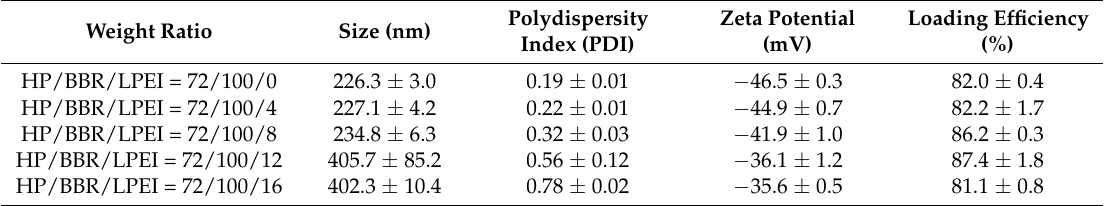
Table 2. Size, zeta potential, and loading efficiency of HP/BBR/LPEI NPs ( n = 3).